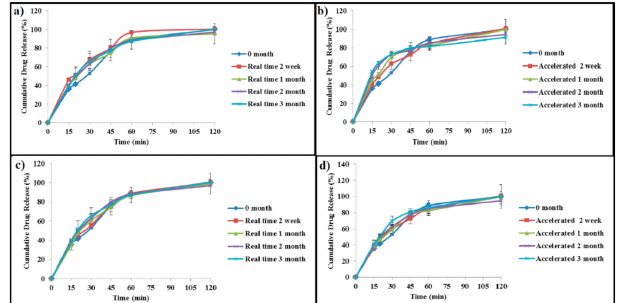
Figure 8. In vitro drug release profile of paracetamol instant jelly samples stored in packaging 1 under ( a ) real-time conditions and ( b ) accelerated conditions and samples stored in packaging 2 under ( c ) real-time conditions and ( d ) accelerated conditions at different time points (0, 2 weeks, 1, 2, and 3 months).